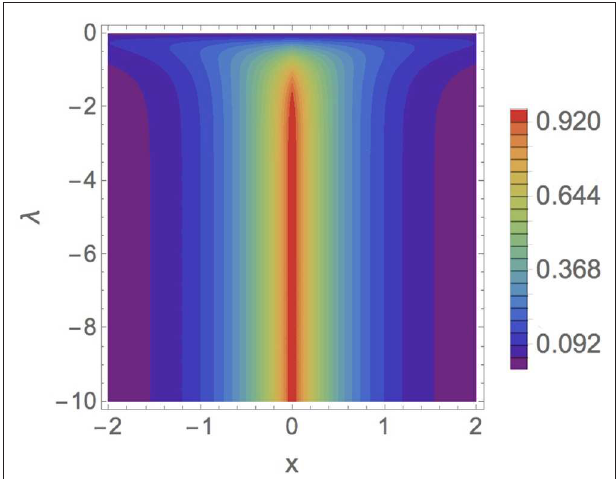
FIGURE 3 | Charge density (58) as a function of x for electrons when Q m 1 and q 0 (mass-spik δ = = =